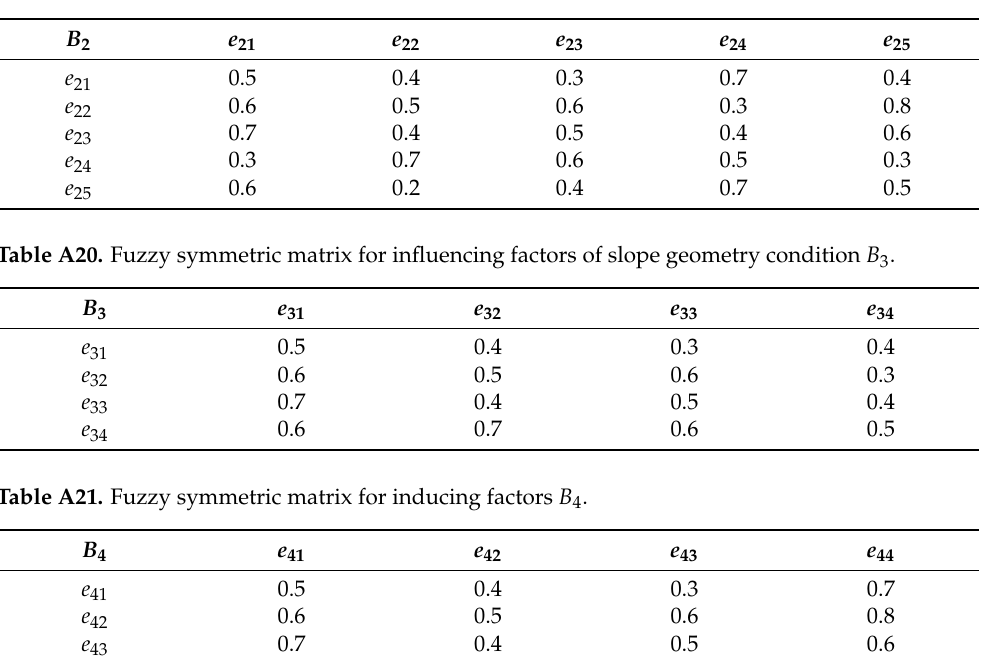
Table A19. Fuzzy symmetric matrix for influencing factors of geological structure in slope B 2 .